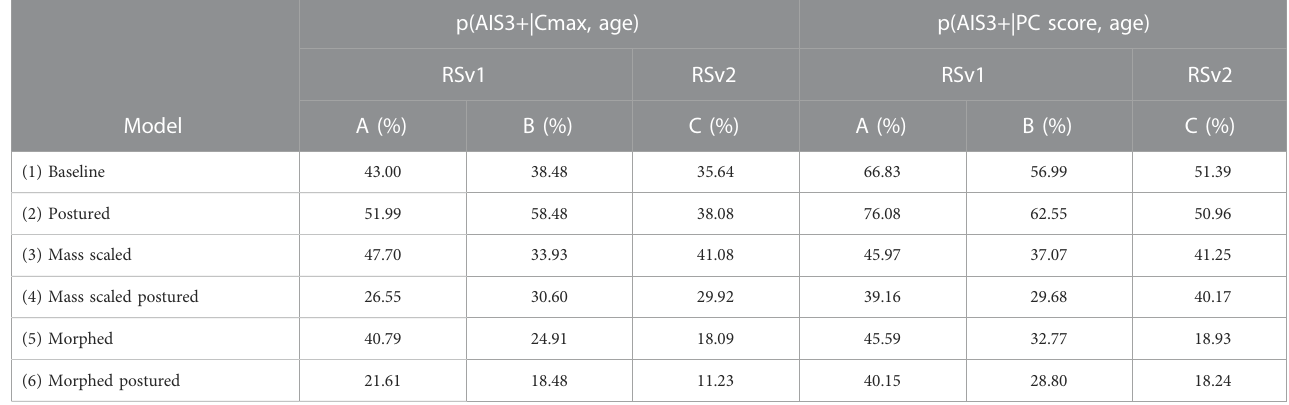
TABLE 6 Probability of AIS3+ for the different model versions based on the Cmax and PC Score metrics.